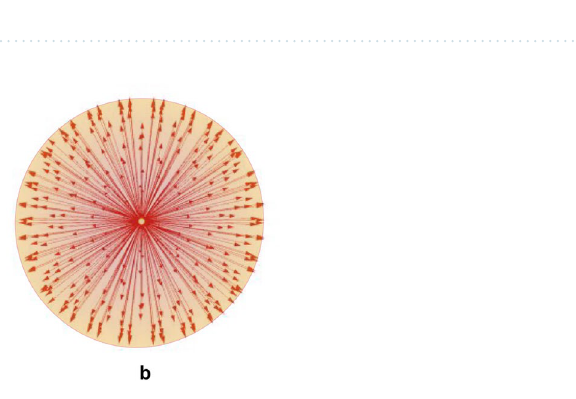
Figure 13. ( a ) 6-pyrgeometer arrangement around a cube to cover the sphere of view from a point in space; ( b ) visualization of the vector-based simulation of MRT used for validation of the ground-truth measurement